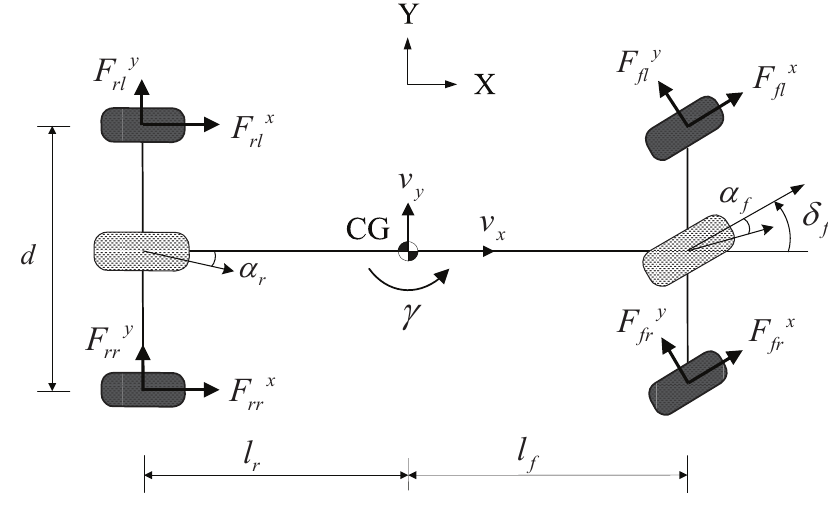
Figure 3. Schematic diagram of the vehicle